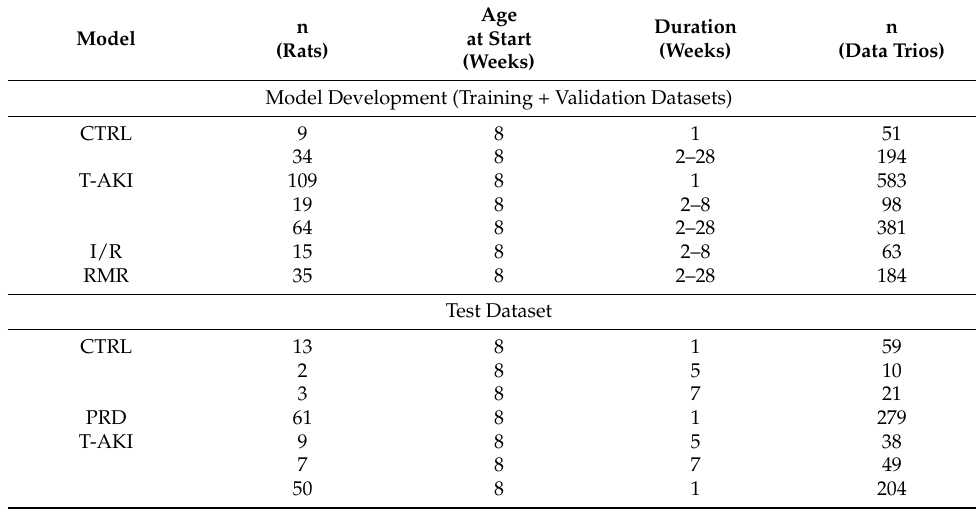
Figure 1. Summary of the datasets used for model development and field testing. Data trios were composed of matched pCr, ClCr, and body weight data. Table 1. Characteristics of the datasets used for model development and field testing. CTRL, control. T-AKI, toxic acute kidney injury. I/R, ischemia/reperfusion. M, male. RMR, 5/6 renal mass reduction. PRD, predisposed-to-AKI (as in [39–42]).